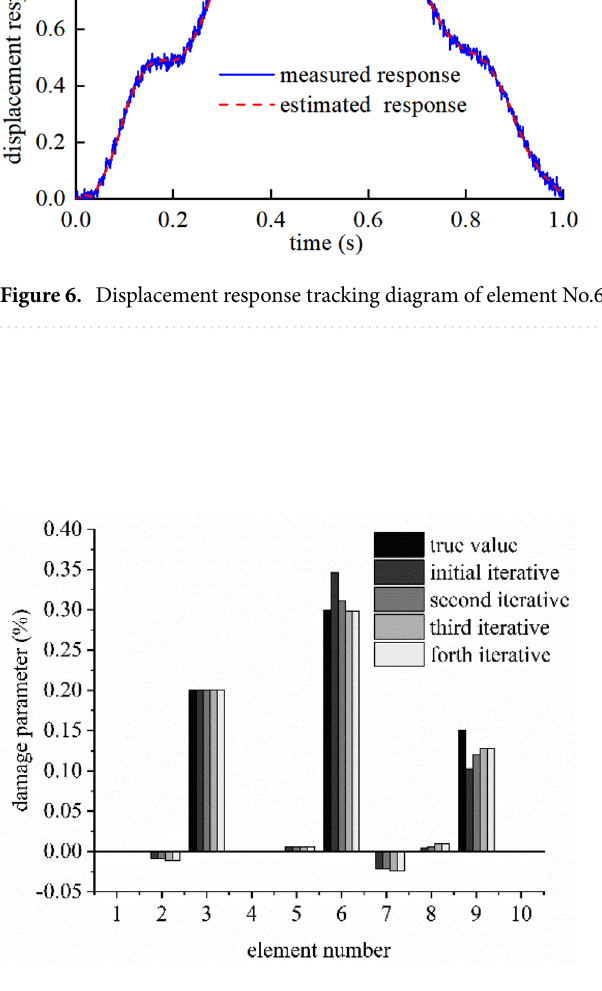
Figure 7. Damage identification result for each iterative process under noise level SNR = 30